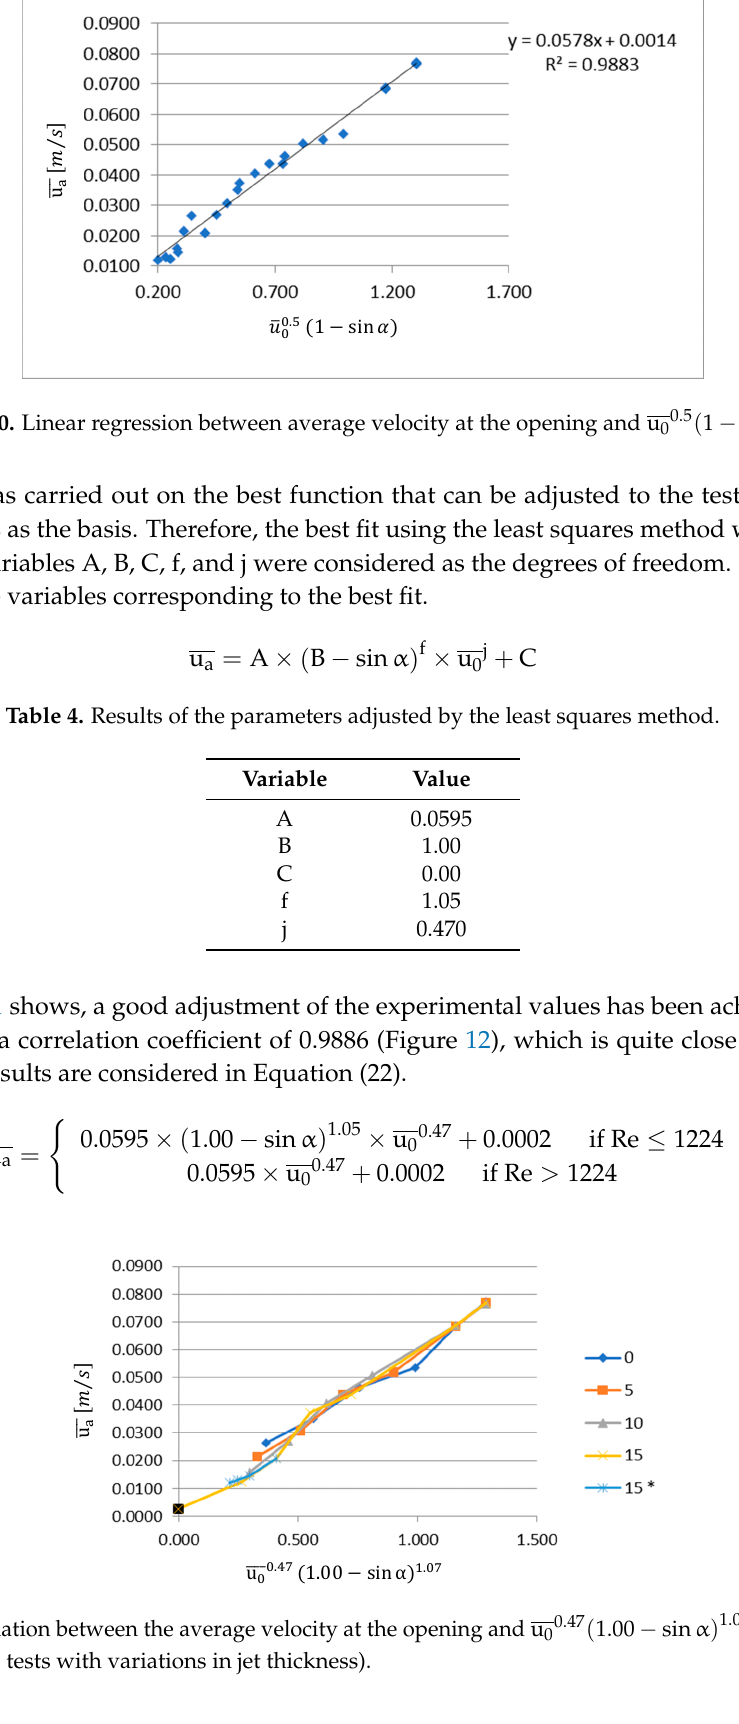
00.47 ( 1.00 − sin α ) 1.07 (15* values